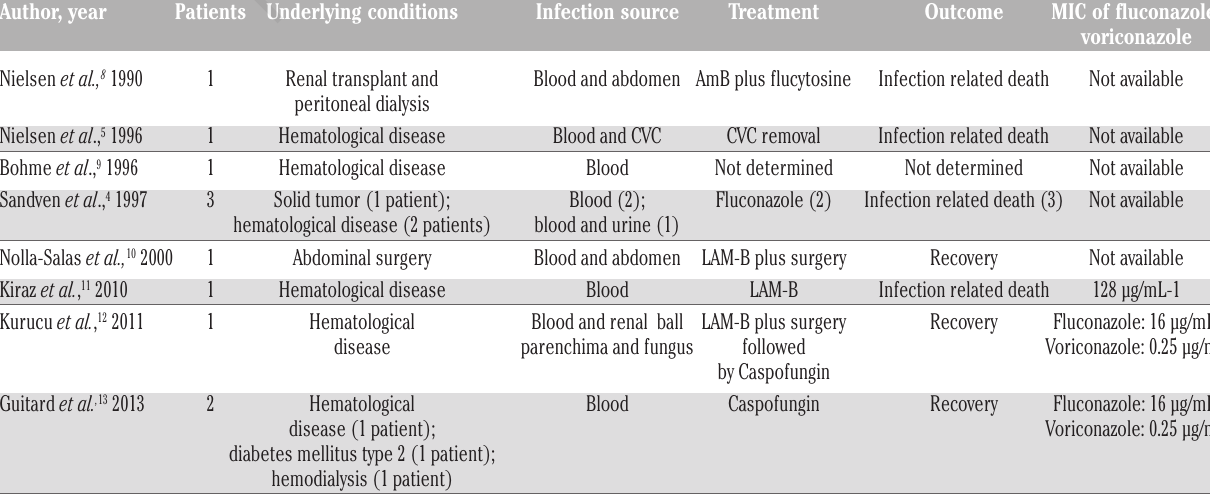
Table 1. Literature cases of invasive candidiasis due to C.